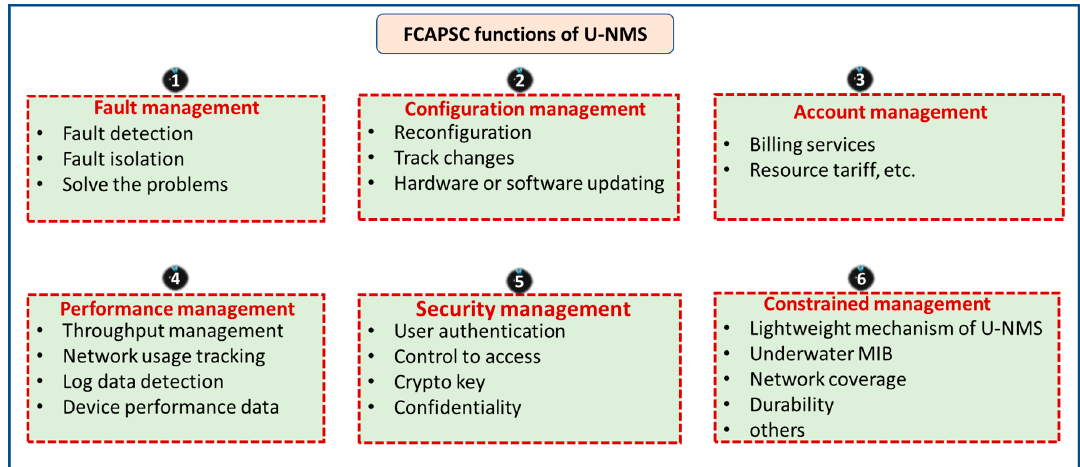
Figure 9. Functions of U-NMS [89] .